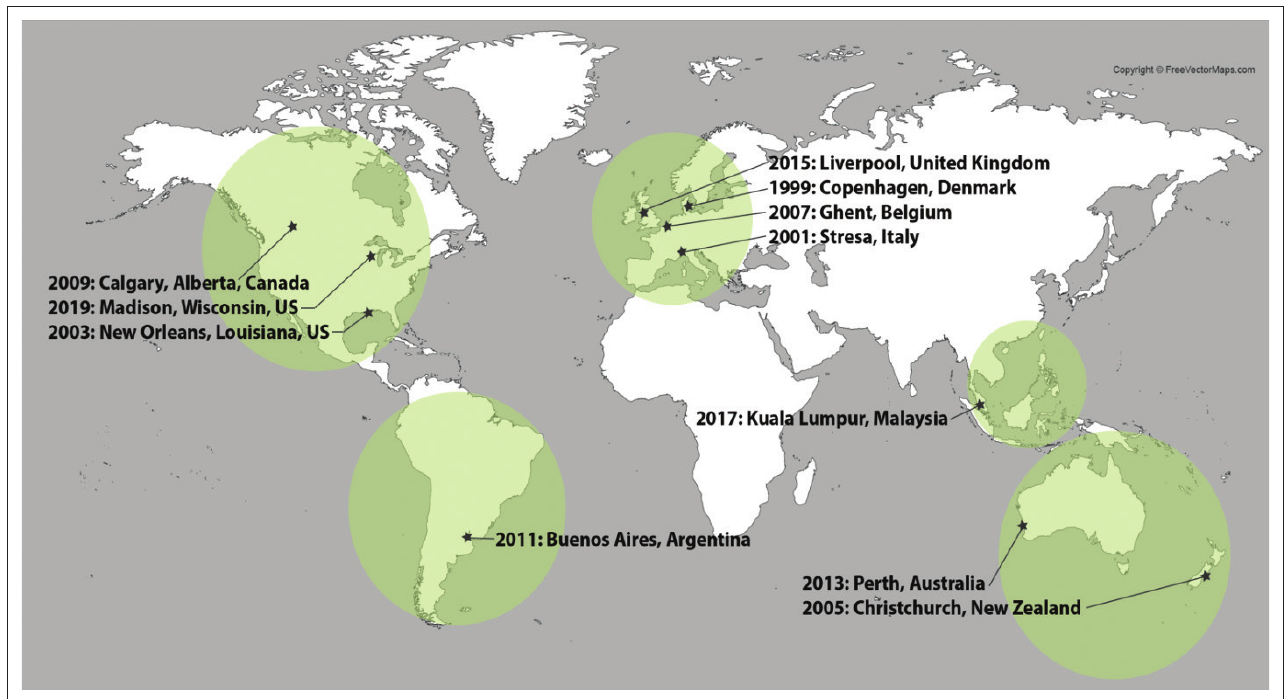
FIGURE 2: World Association for the Advancement of Veterinary Parasitology African Foundation awardees have presented their research at 11 International World Association for the Advancement of Veterinary Parasitology conferences globally from 1999 to 2019 (number of awardees). 2019: Madison, WI, United States (7); Kuala Lumpur, Malaysia (5); 2015: Liverpool, United Kingdom (7); 2013: Perth, Australia (8); 2011: Bueno Aires, Argentina (4); 2009: Calgary, Canada (10); 2007: Ghent, Belgium (8); 2005: Christchurch, New Zealand (4); 2003: New Orleans, LA, United States (10); 2001: Stresa, Italy (8); 1999: Copenhagen, Denmark